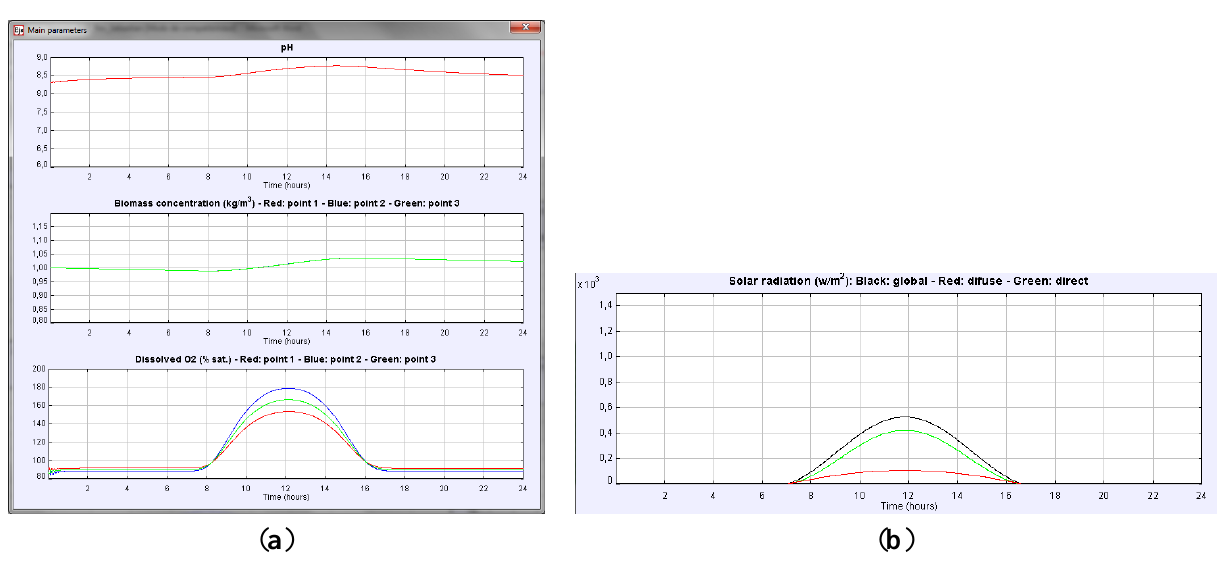
Figure 6. ( a ) Evolution of the main variables. ( b ) Intensity of the horizontal solar radiation in W/m 2 on the PBR along the interval of days selected in the simulation.